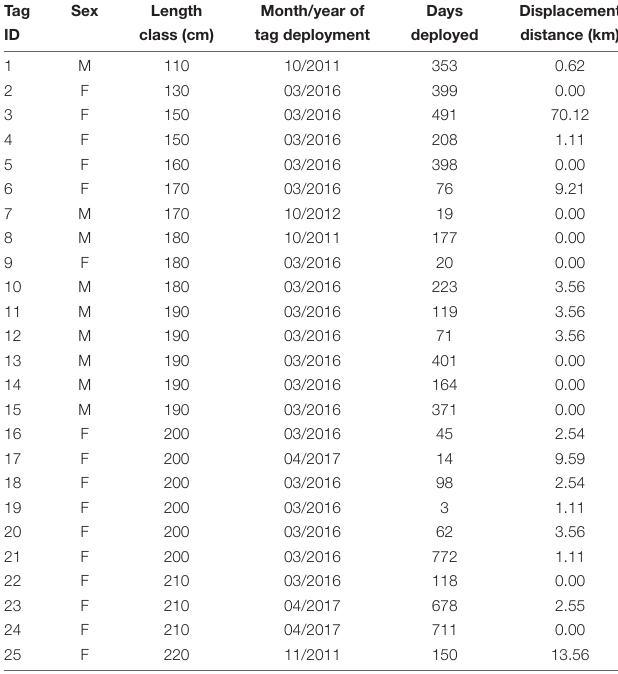
TABLE 1 | Metadata for skate for which tag data were recovered and used in this